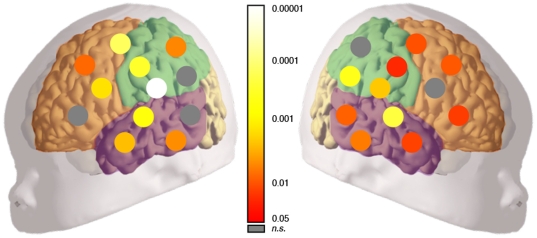
Statistical maps on the schematic neonate brain.The graph depicts the comparison between the Novel-word and Same-word conditions in the first block of the test -block 11, Study 1-. Significance levels for each channel (p-values corrected by false discovery rate [38]) are color-coded as indicated on the color bar. Grey circles indicate no significant differences between conditions.